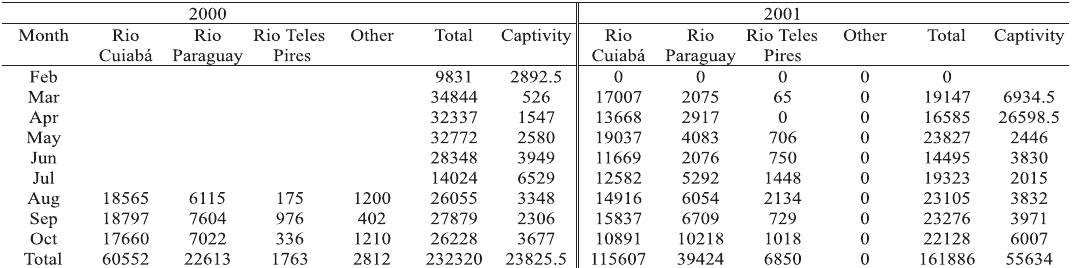
Table 1. Total fish landed (kg) in the Cuiabá Fish Market in 2000 and 2001 per month, river and year from commercial fishing and